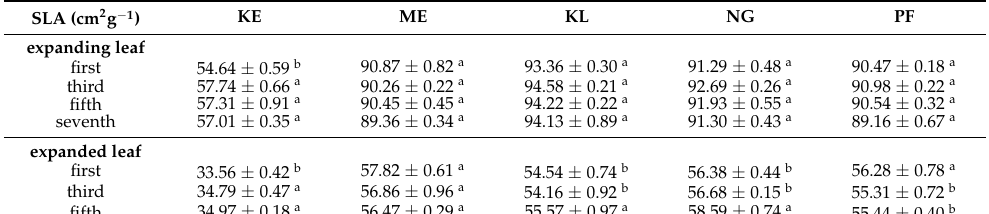
Table 3. Specific leaf area (SLA) of expanding and expanded compound leaves of C. siliqua ; the values are means of 30 replicates ± standard deviation. Different lower-case, superscript letters next to each value correspond to statistically significant differences of SLA in each developmental stage, that is, expanding and expanded leaflets in each research site (one-way ANOVA, t-test at p < 0.05; for all cases n = 30).